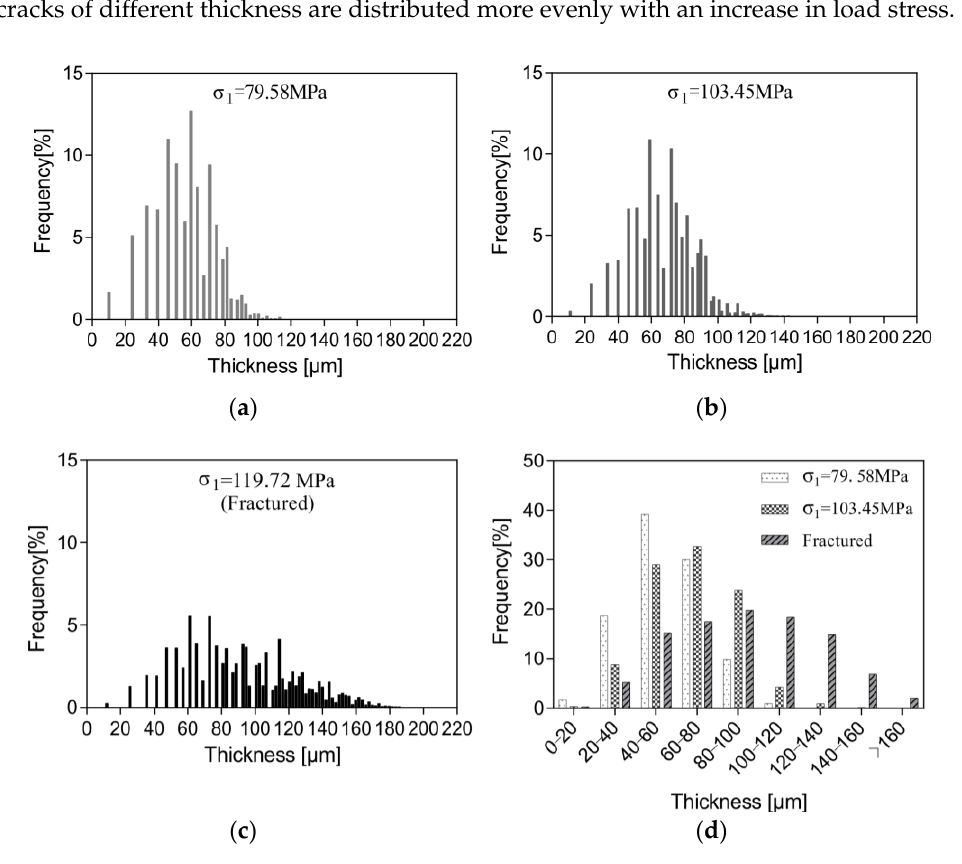
Figure 7. The thickness of crack in different load stages in SZA3. ( a ) σ 1 = 79.58 MPa; ( b ) σ 1 = 103.45 MPa; ( c ) Fractured (after σ 1 = 119.72 MPa); ( d ) The frequency of all stages at the interval of 20 μm.